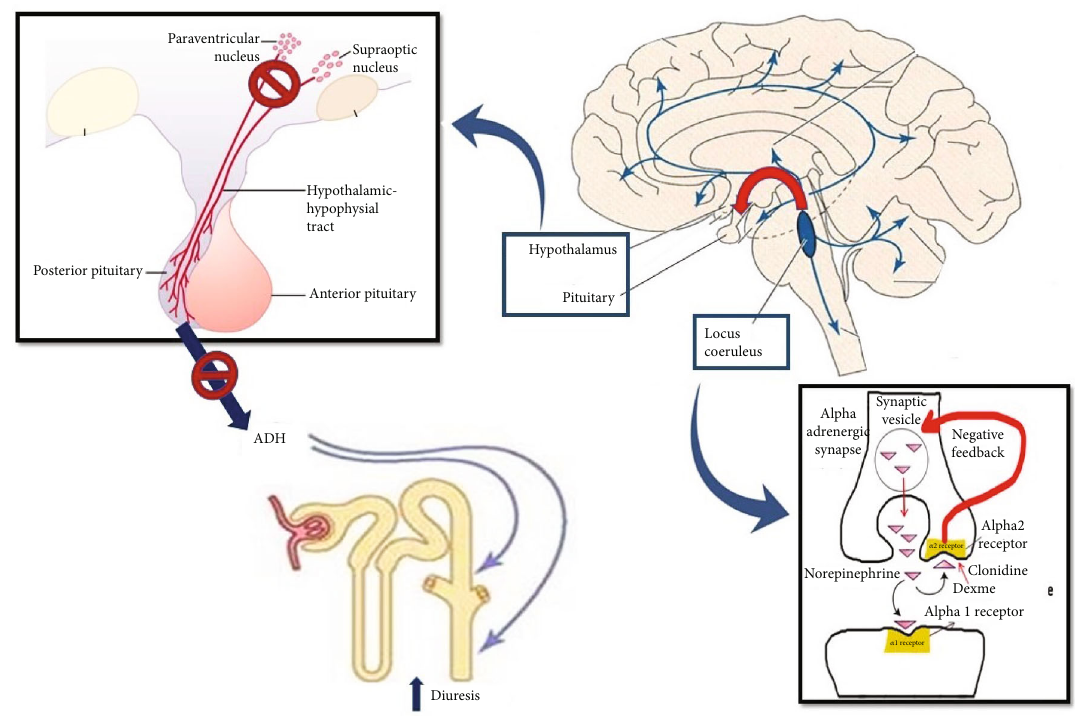
Figure 1: Neural pathways involved in dexmedetomidine-induced central diabetes